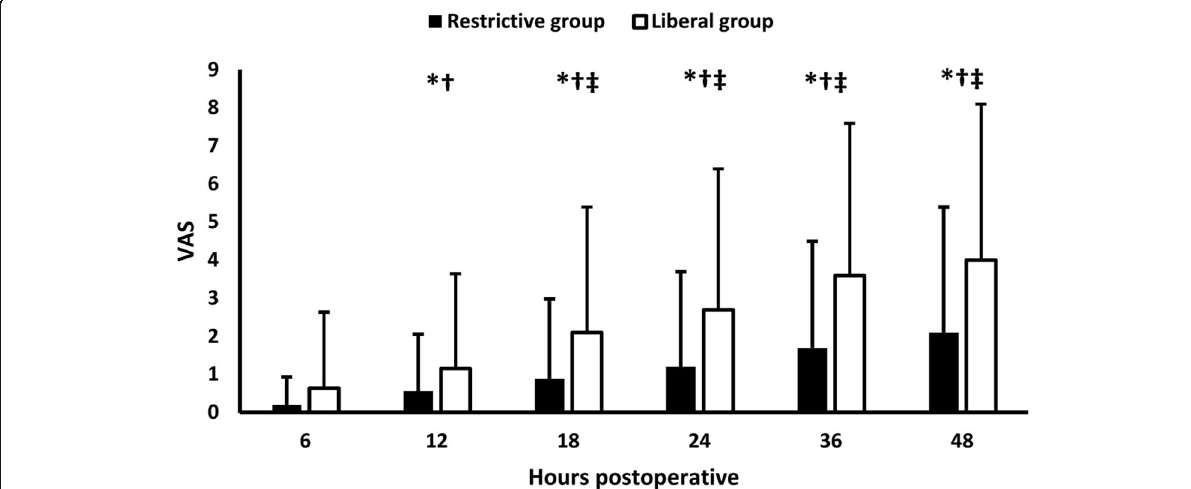
Fig. 4 Pain score. * denotes statistical significance compared to the baseline reading within restrictive group. † denotes statistical significance compared to the baseline reading within liberal group. ‡ denotes statistical significance between both